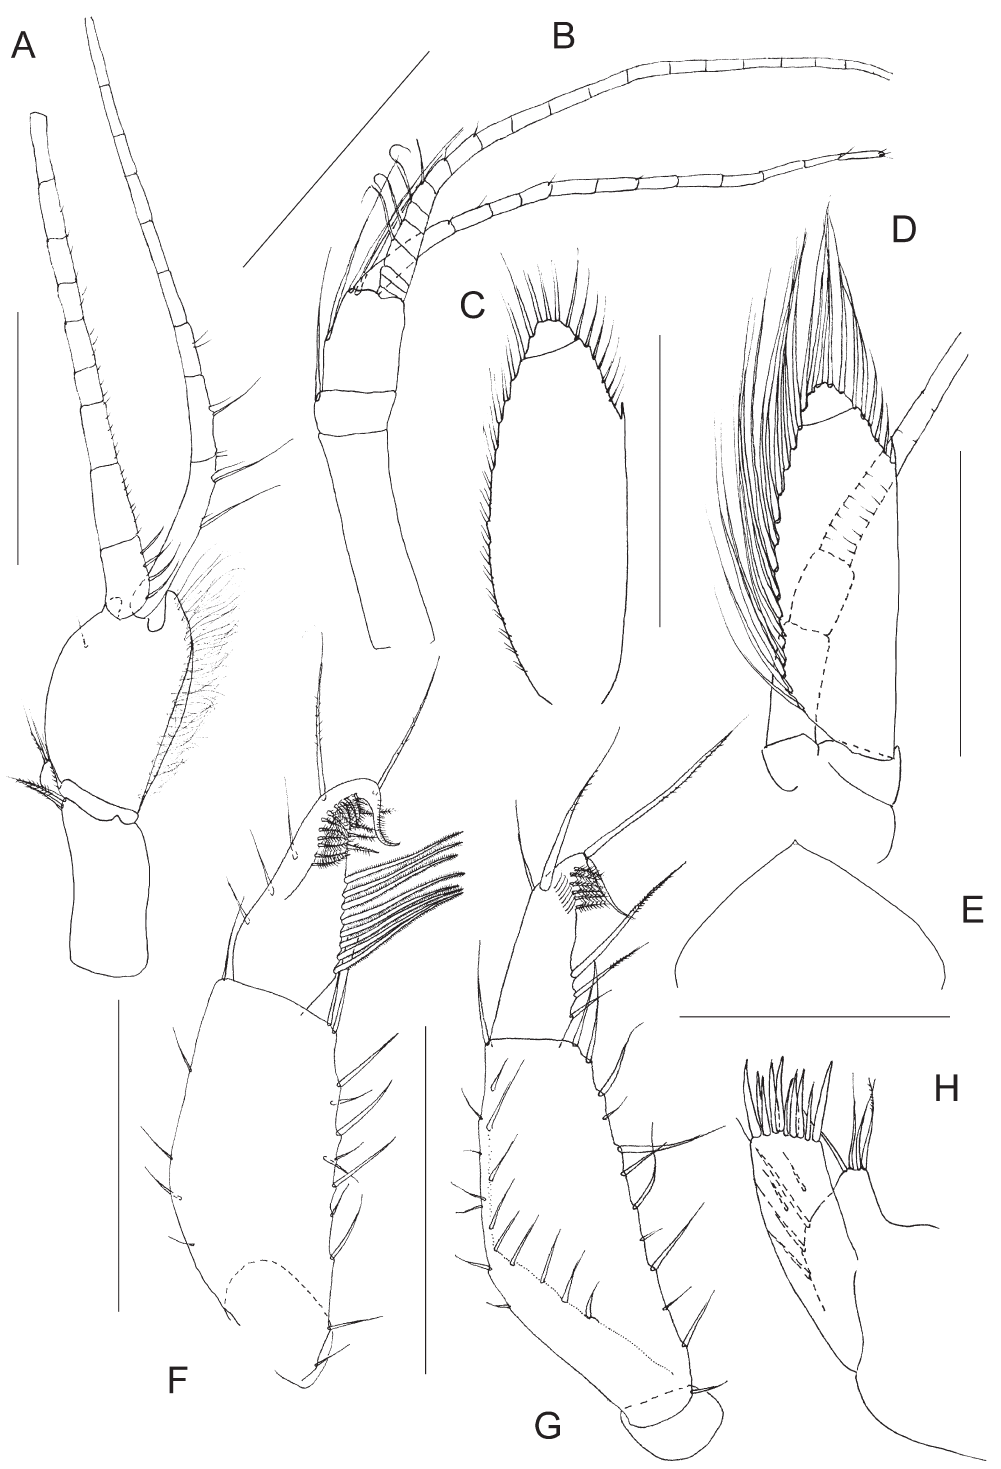
Fig. 8. Siriella brevicaudata Paulson, 1875, Arabian Gulf, Bahrain. A . Antenna 1, lateral view. B . Antenna 1, dorsal view. C . Antennal scale. D . Antenna 2 (peduncle and antennal scale), ventral view. E . Labrum. F . Mandibular palp, lateral view. G . Mandibular palp, medial view. H . Maxilla 1, anterior view. A, C, E–F, H = ♂, length 4.5 mm; B, D, G = ♀, length 4 mm. Scale bars: A–D, F–G = 0.5 mm; E, H = 0.25